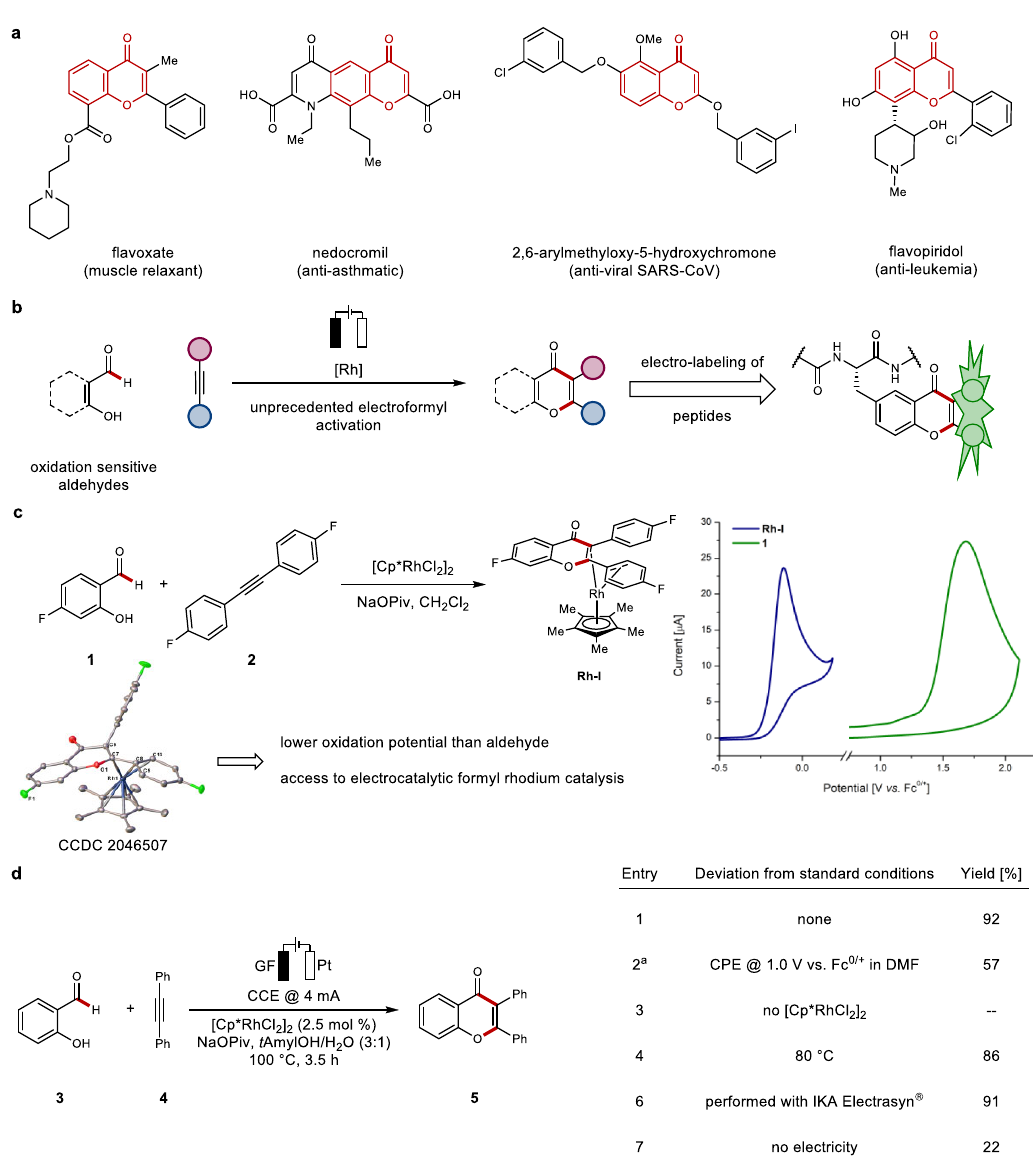
Fig. 1 Motivation, rationale, and development of rhodaelectro-catalyzed annulation of benzaldehydes. a Chromones as a privileged motive in pharmaceutical and bioactive compounds. b Strategy to access chromones via rhodaelectro catalysis and its use for electro-peptide labeling. c Synthesis of rhodium complex Rh-I and investigations of its redox properties by cyclic voltammetry in CH 2 Cl 2 with n Bu 4 NPF 6 (0.2 M ). d Reaction development, 0.25 – 0.50 mmol scale, 4.0 – 8.0 mL solvent, isolated yields. a With n Bu 4 NPF 6 (0.1 M ) for 4 h. Cp* pentamethylcyclopentadienyl, NaOPiv sodium pivalate, Fc ferrocene, GF graphite felt electrode, CCE constant current electrolysis, CPE constant potential electrolysis, t AmylOH